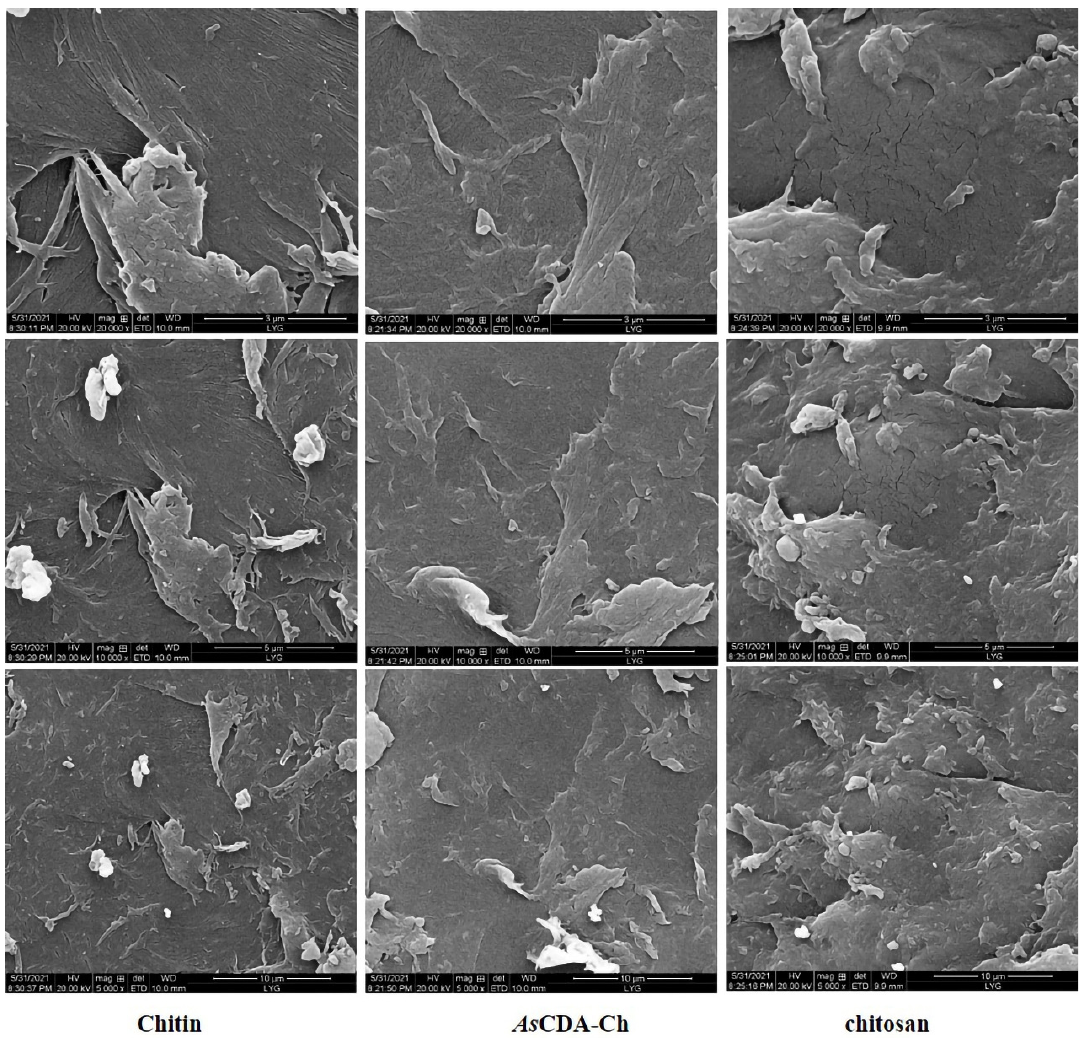
Figure 5. SEM images of untreated chitin, chitin treated by As CDA, and chitosan with magnificent × 20,000 times, × 10,000 times, and × 5000 ×20,000 times, ×10,000 times, and ×5000 times.